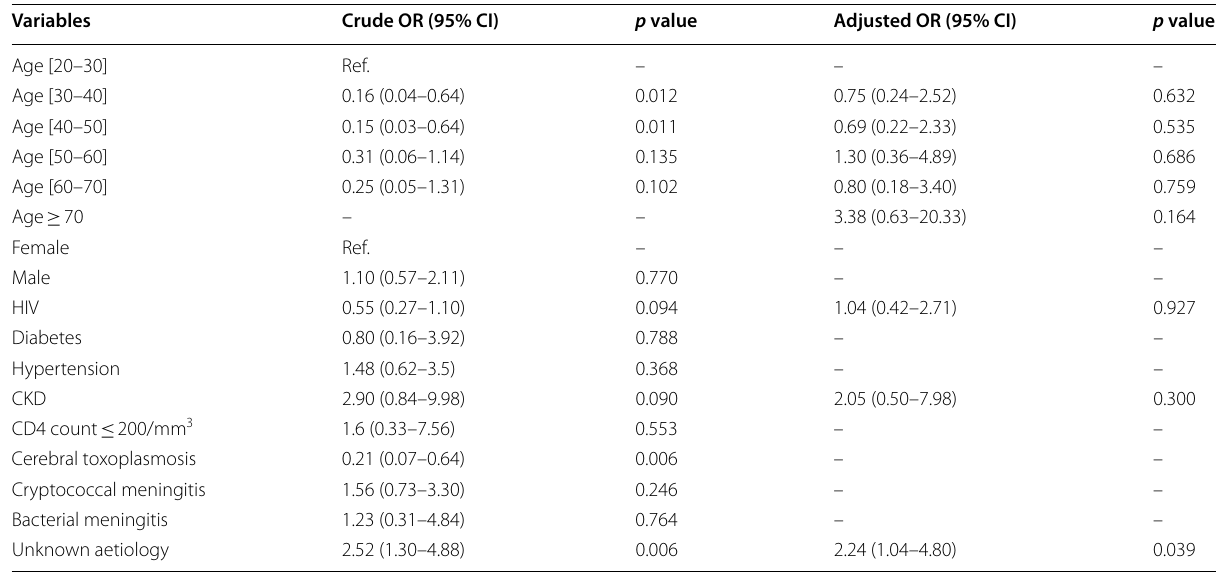
CKD chronic kidney disease, HIV human immunodeficiency virus